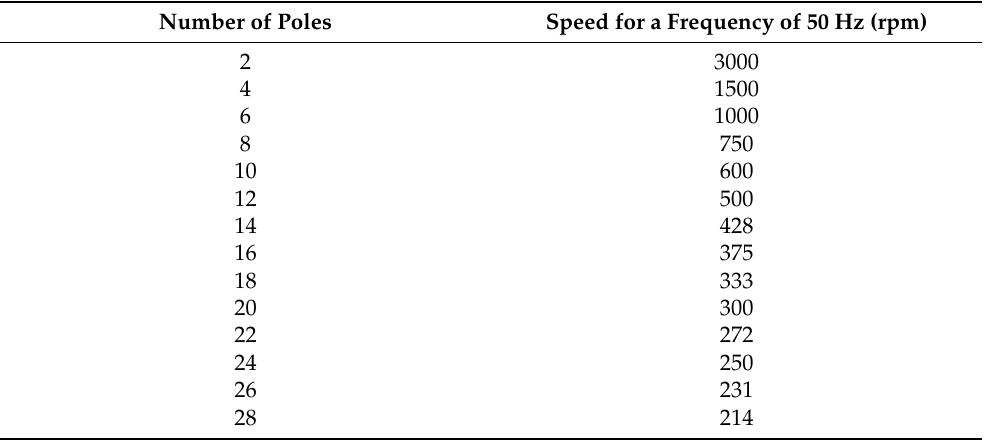
Table 3. Generator synchronization